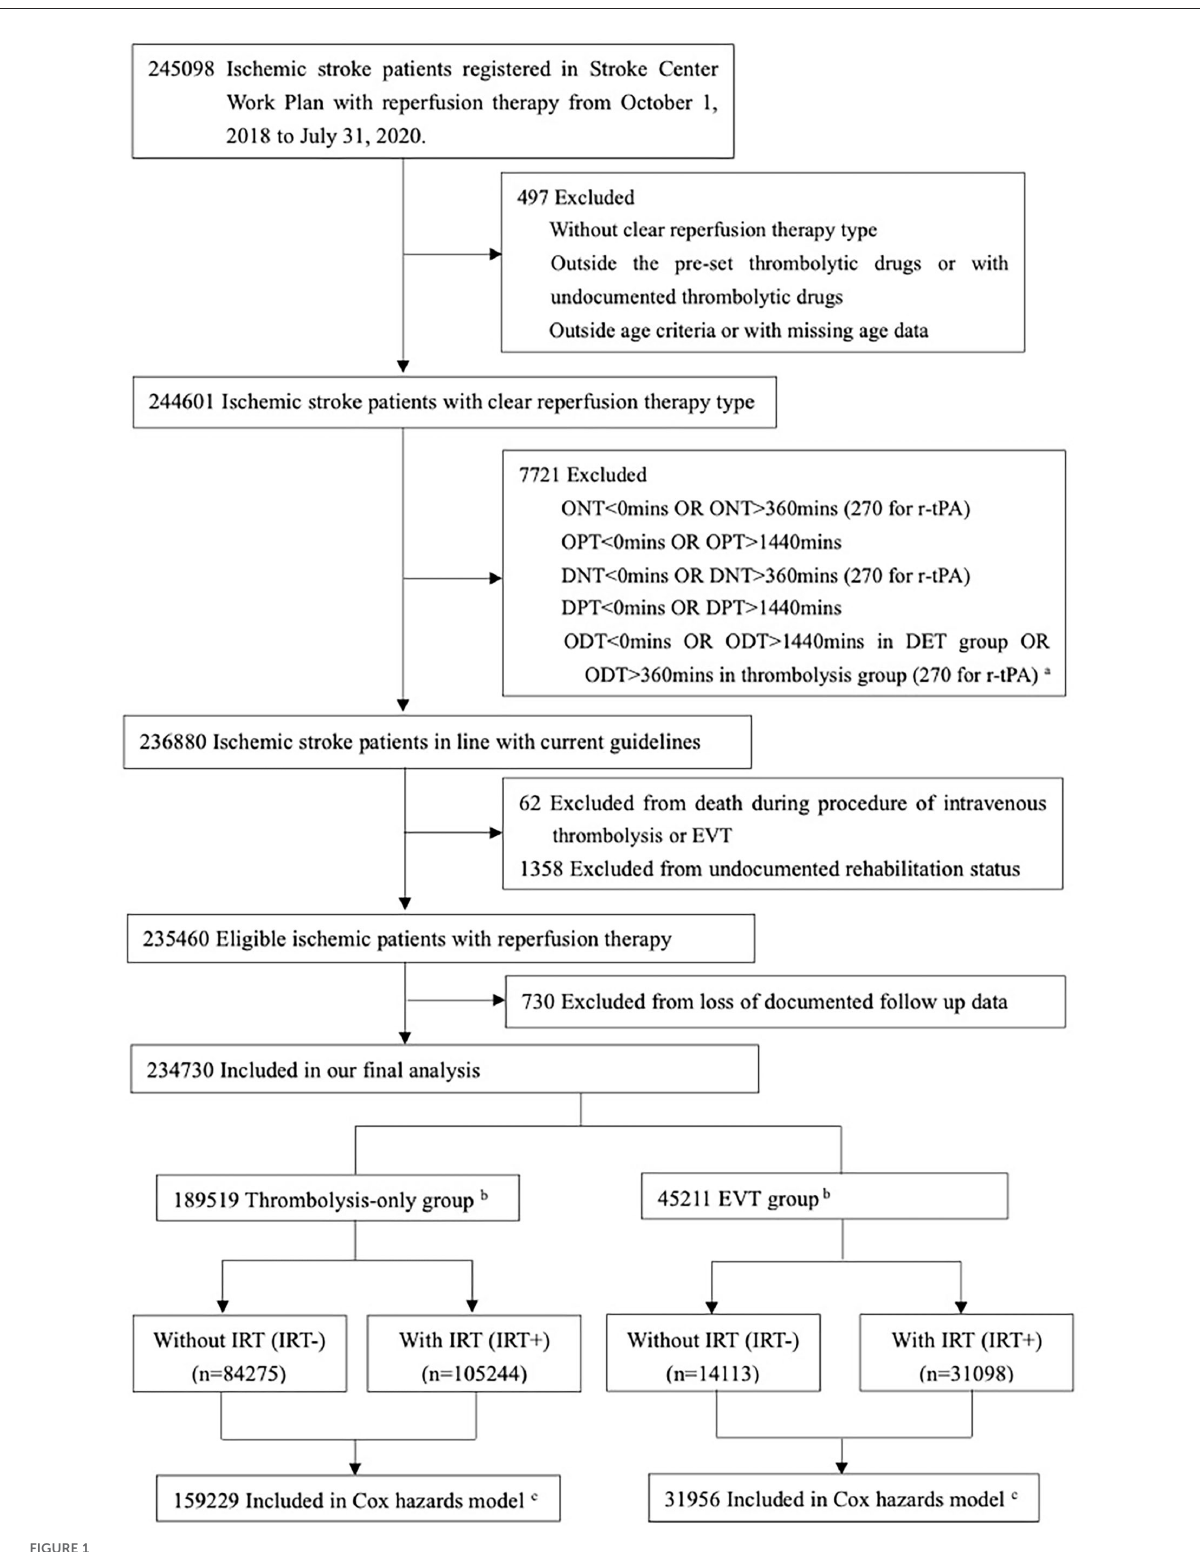
FIGURE1 Flow of patients in our study. a r-tPA: recombinant tissue plasminogen activator. b Thrombolysis-only group for patients with intravenous thrombolysis and without endovascular therapy; EVT group for patients with endovascular therapy and with/without intravenous thrombolysis. c Excluded from Cox proportional hazards models because of missing data on patient-level characteristics and follow-up